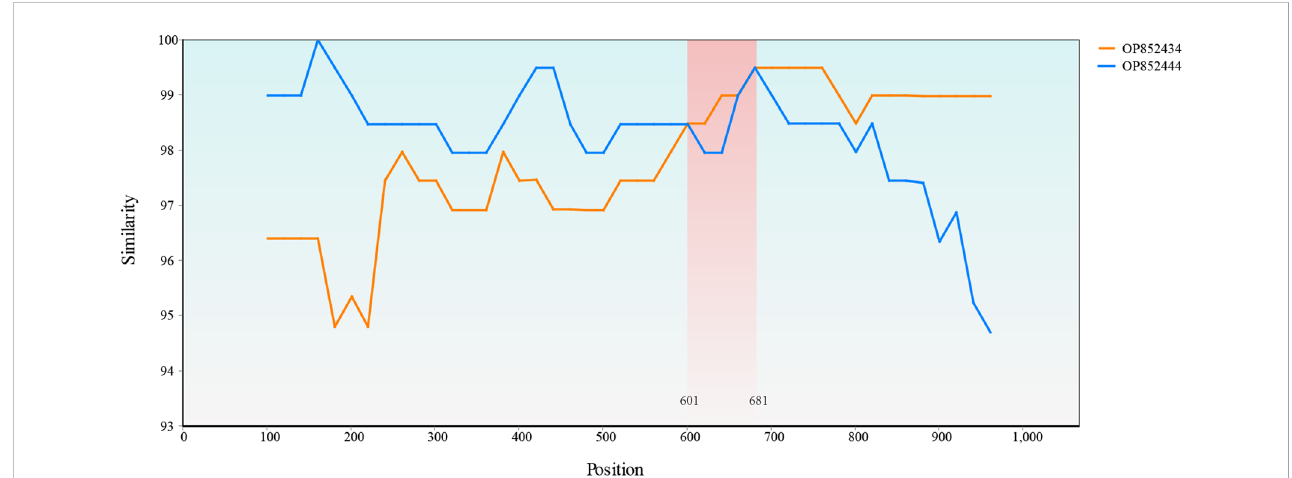
FIGURE 8 Simplot evidence for recombination event. Recombination analysis of the OP852439. The recombinant breakpoints were located at 601 bp and 681